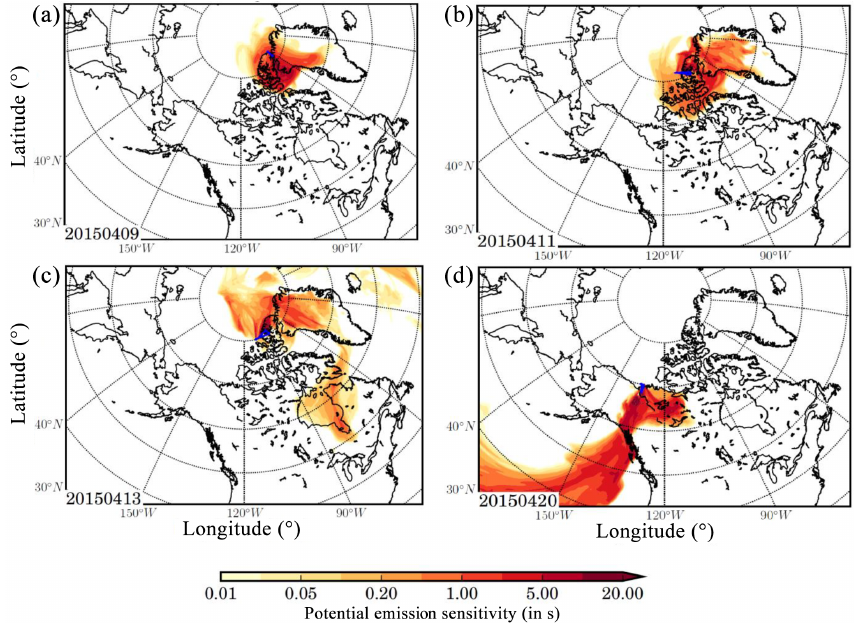
Figure 7. FLEXPART-ECMWF potential emissions sensitivity simulation plots for 4-day back trajectories for column from 0 to 1000m on (a) 9 April (14:45:00UTC), (b) 11 April (18:55:00UTC), (c) 13 April (18:27:00UTC) and (d) 20 April (22:26:00UTC) 2015. The colour bars indicate air mass residence time (seconds) before arriving at the aircraft location. The blue lines show Polar 6 aircraft routes.